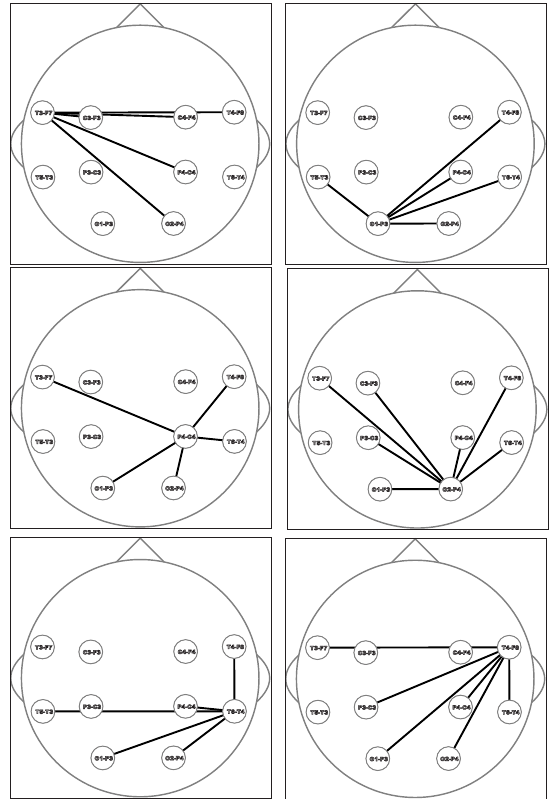
Fig. 1. Clusters selected using the size criterion. The clusters se- lected using the weight criterion are essentially the same except for the T3-F7 (top left) which is only selected on the basis of the size criterion. One can notice that the cluster with the smallest size (4) is discarded from the set of clusters on the basis of the weight criterion. Other clusters have sizes (or degrees) ranging from 5 to 7.